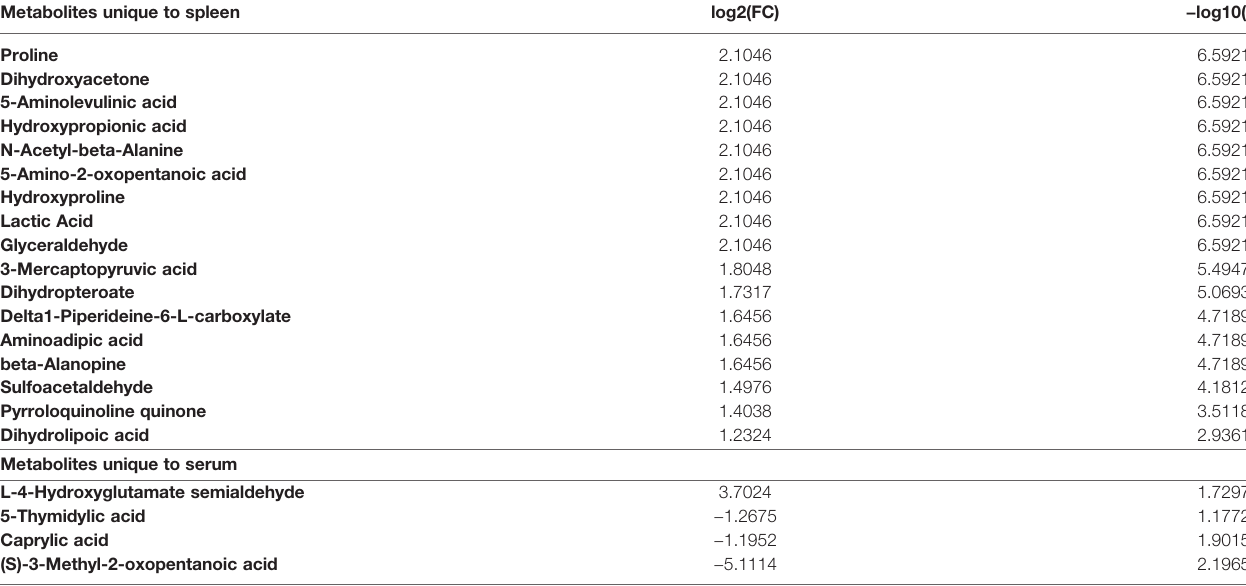
TABLE 2 | Unique metabolites identi fi ed in Spleen and Serum (Control vs